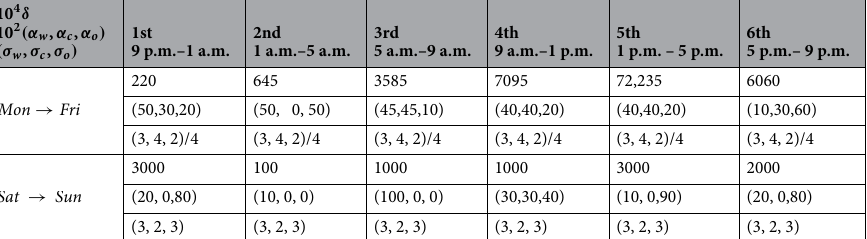
Table 1. Parameter values used in Fig. 1 and obtained from the references listed in Table 4, found at the end of the “Numerical results” section.